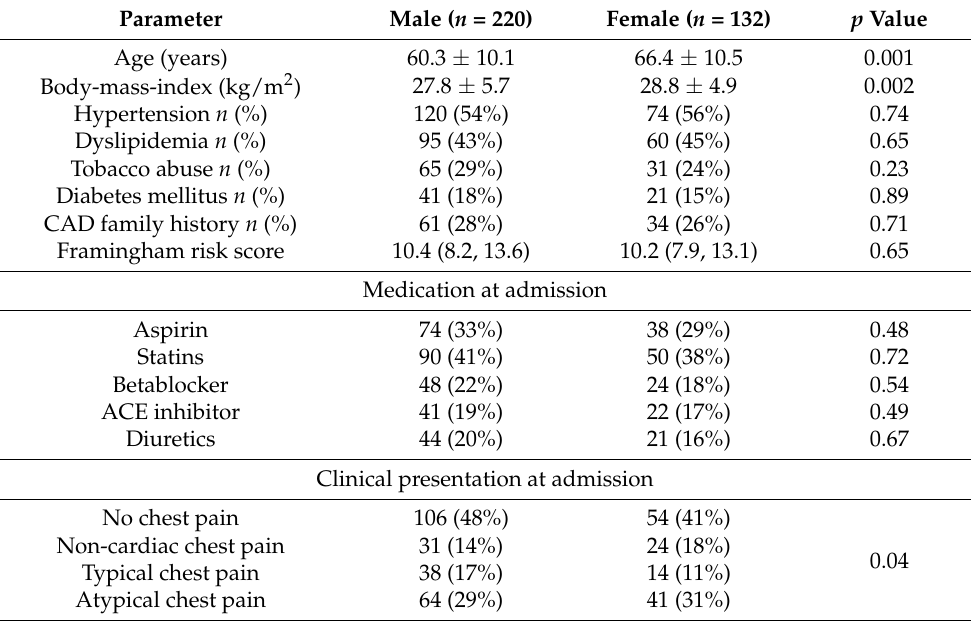
Table 1. Patient demographics. Total patient cohort ( n = 352).